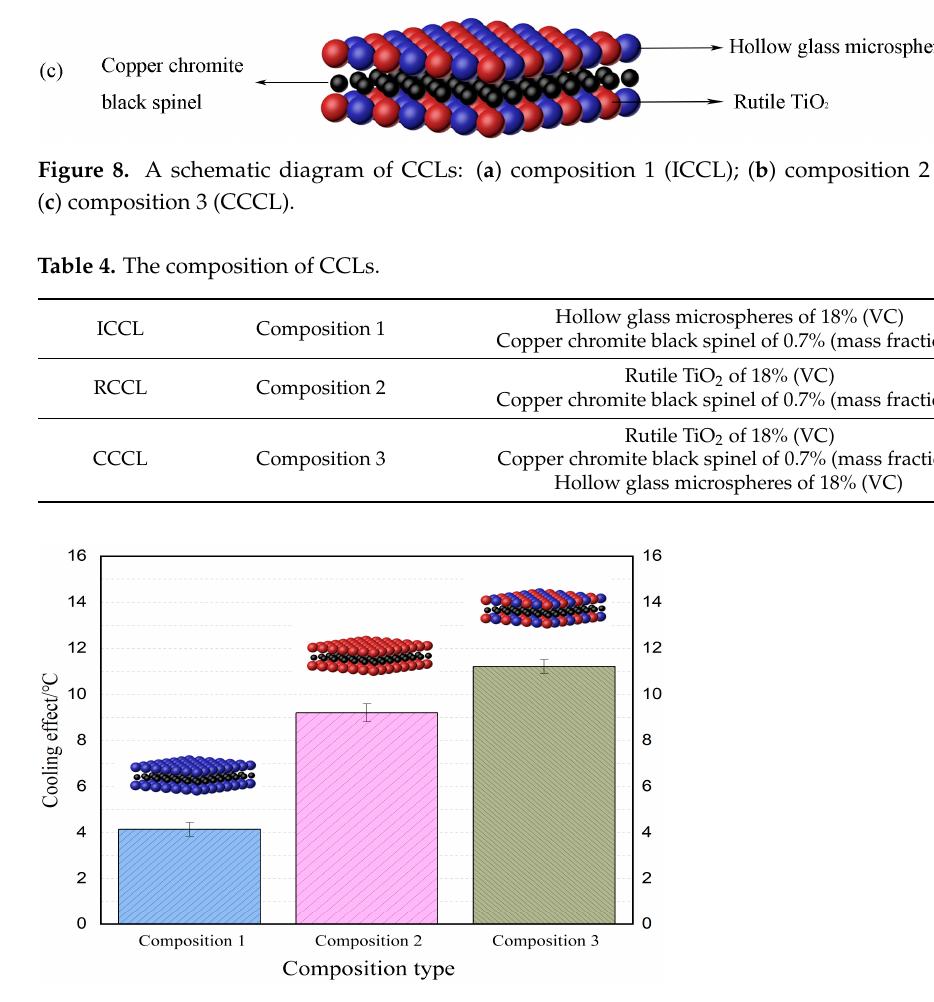
Figure 9. Cooling effect (°C) of CCLs.